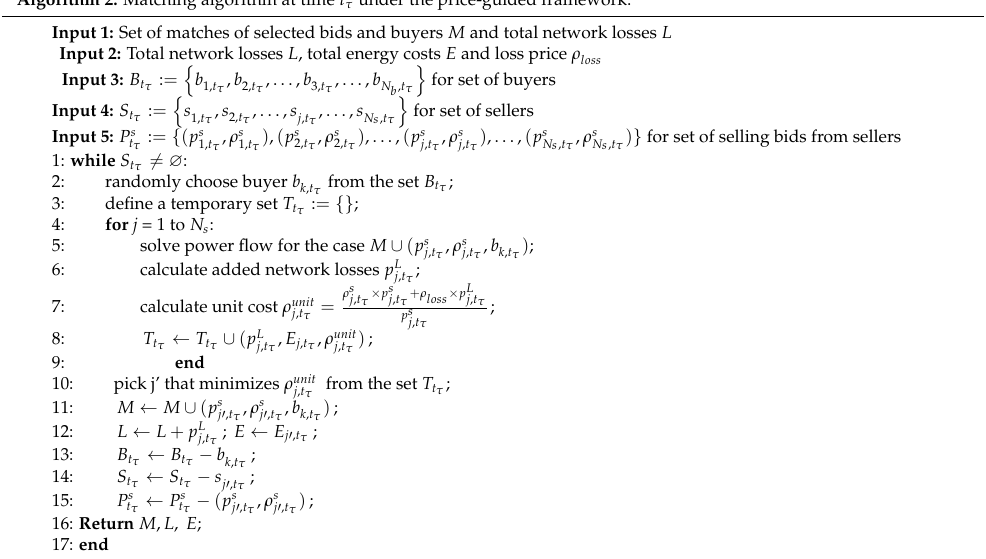
Algorithm 2: Matching algorithm at time t τ under the price-guided